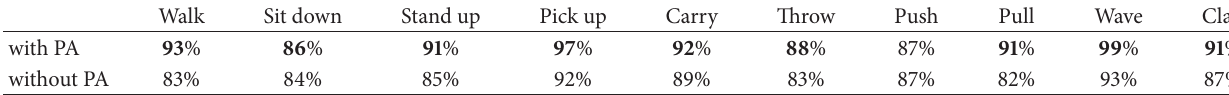
Table 1: Results of action recognition with or without Procrustes analysis.